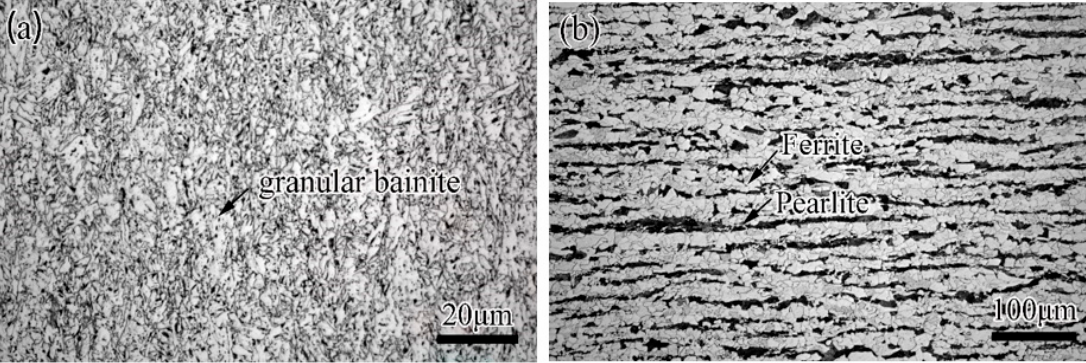
Figure 1. Schematic representation of type-B sleeve repair welding: ( a ) mock-up, ( b ) fillet weld. Table 1. Chemical compositions (in wt%) of X80, Q345B and E5515-G deposited metal.